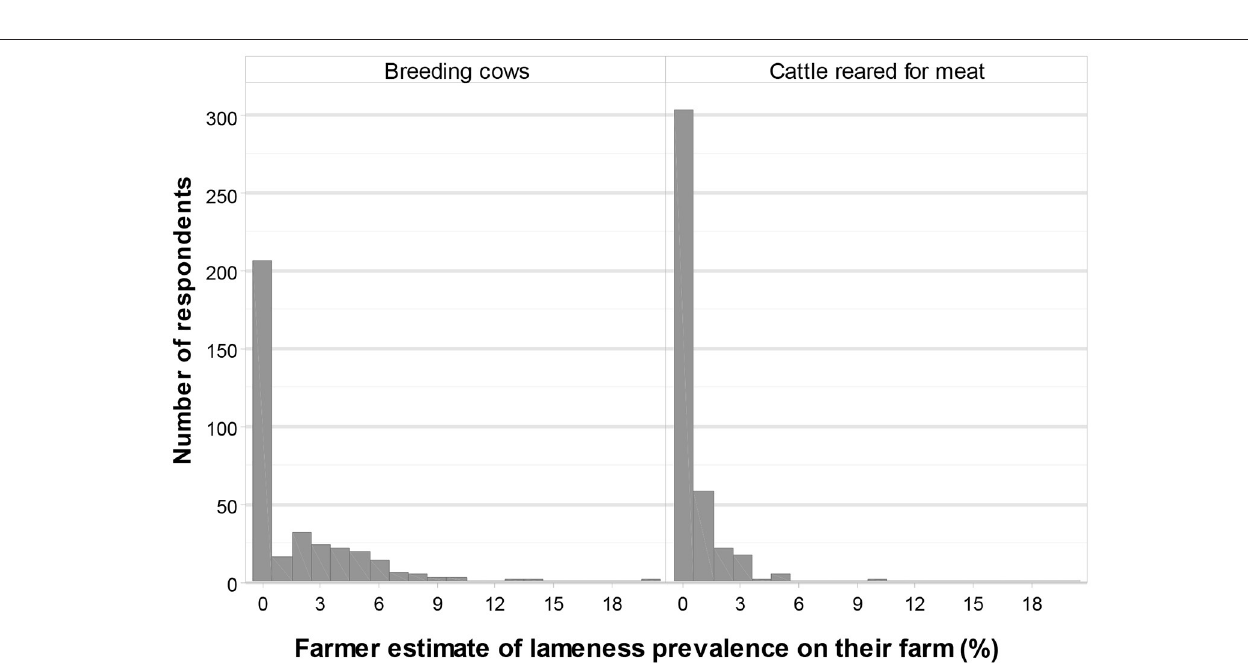
FIGURE 3 | Farmer-reported number of beef cattle of interest on their farm, subdivided by type of cattle: (i) breeding cows and pregnant heifers and (ii) cattle reared for meat, from weaning to slaughter (Q16, n = 376 and n = 441).